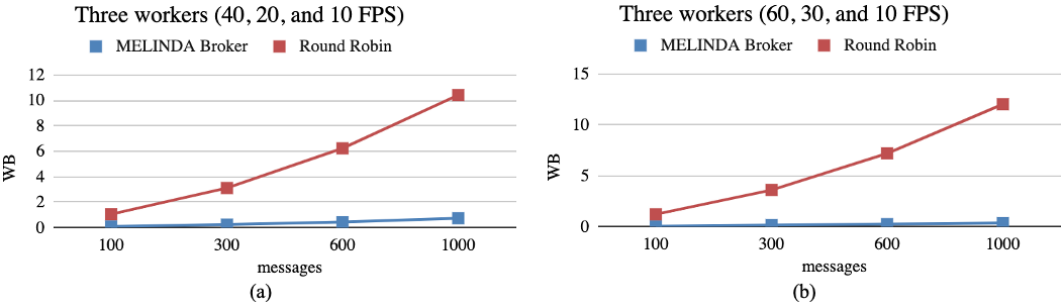
Figure 9. Workload balancing with heterogeneous nodes, where the difference in processing capacity between the fastest and the slowest is 4 × ( a ) and 6 × ( b ).